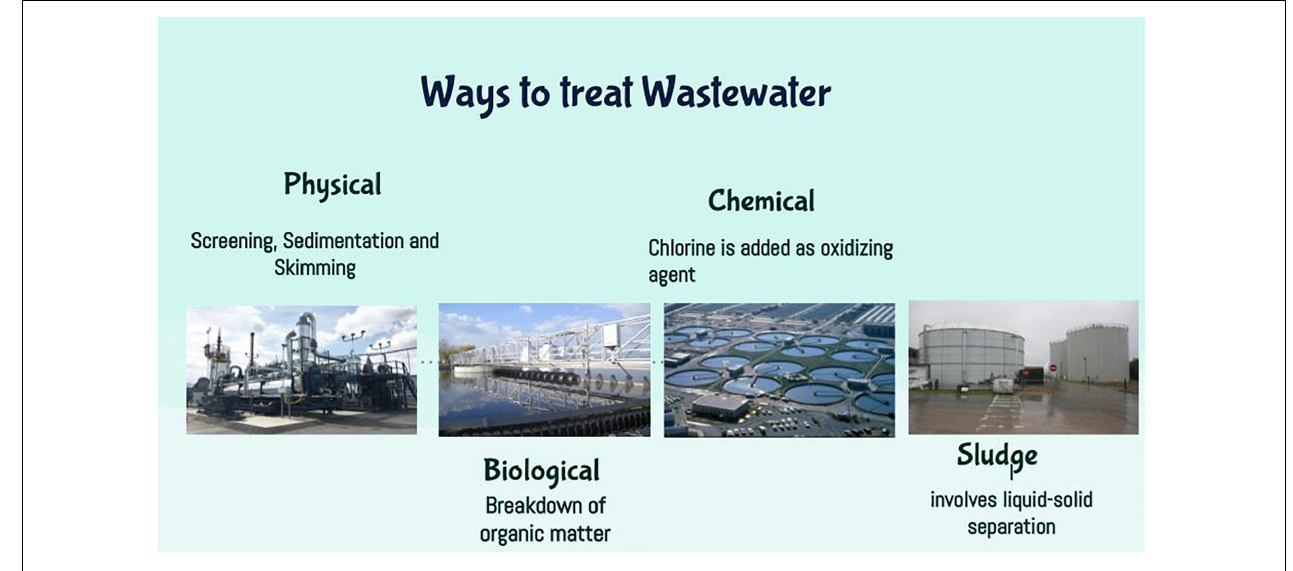
FIGURE 1 | Ways to treat